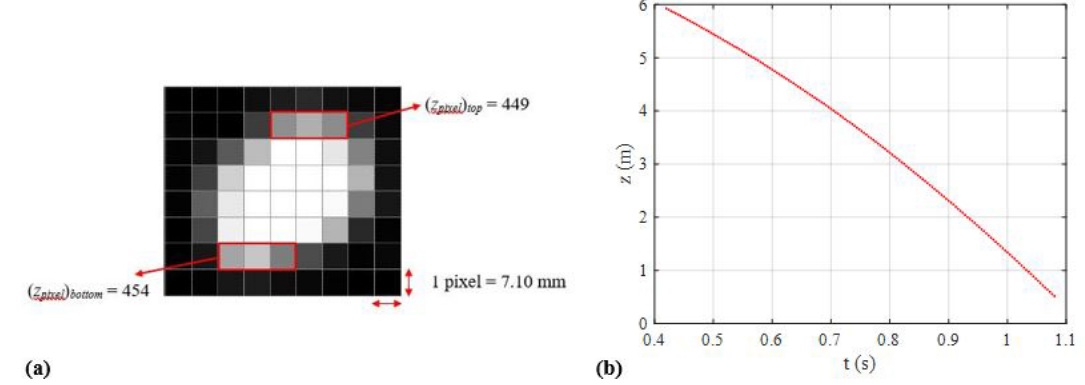
Figure 6. (a) Example of a position measurement for the hoary bat and (b) plotted measurements of time vs.